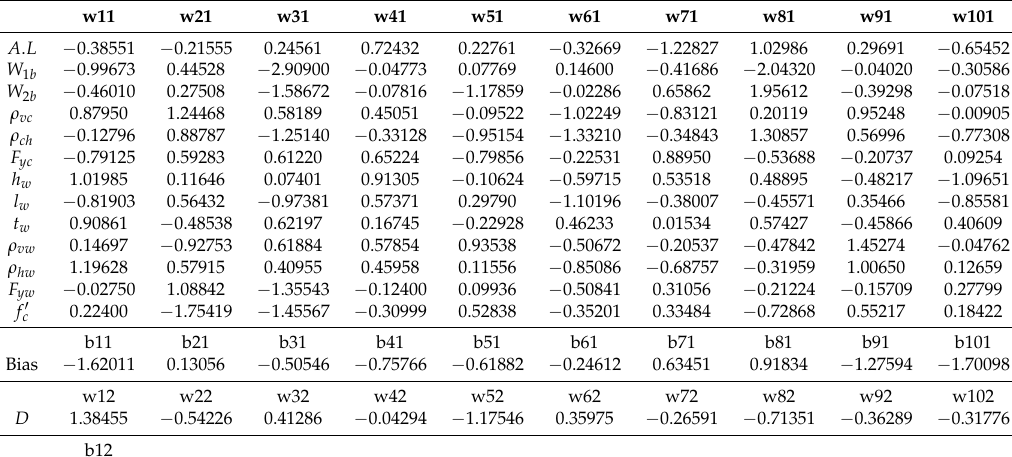
Table A7. Detailed meta-model for drift response of